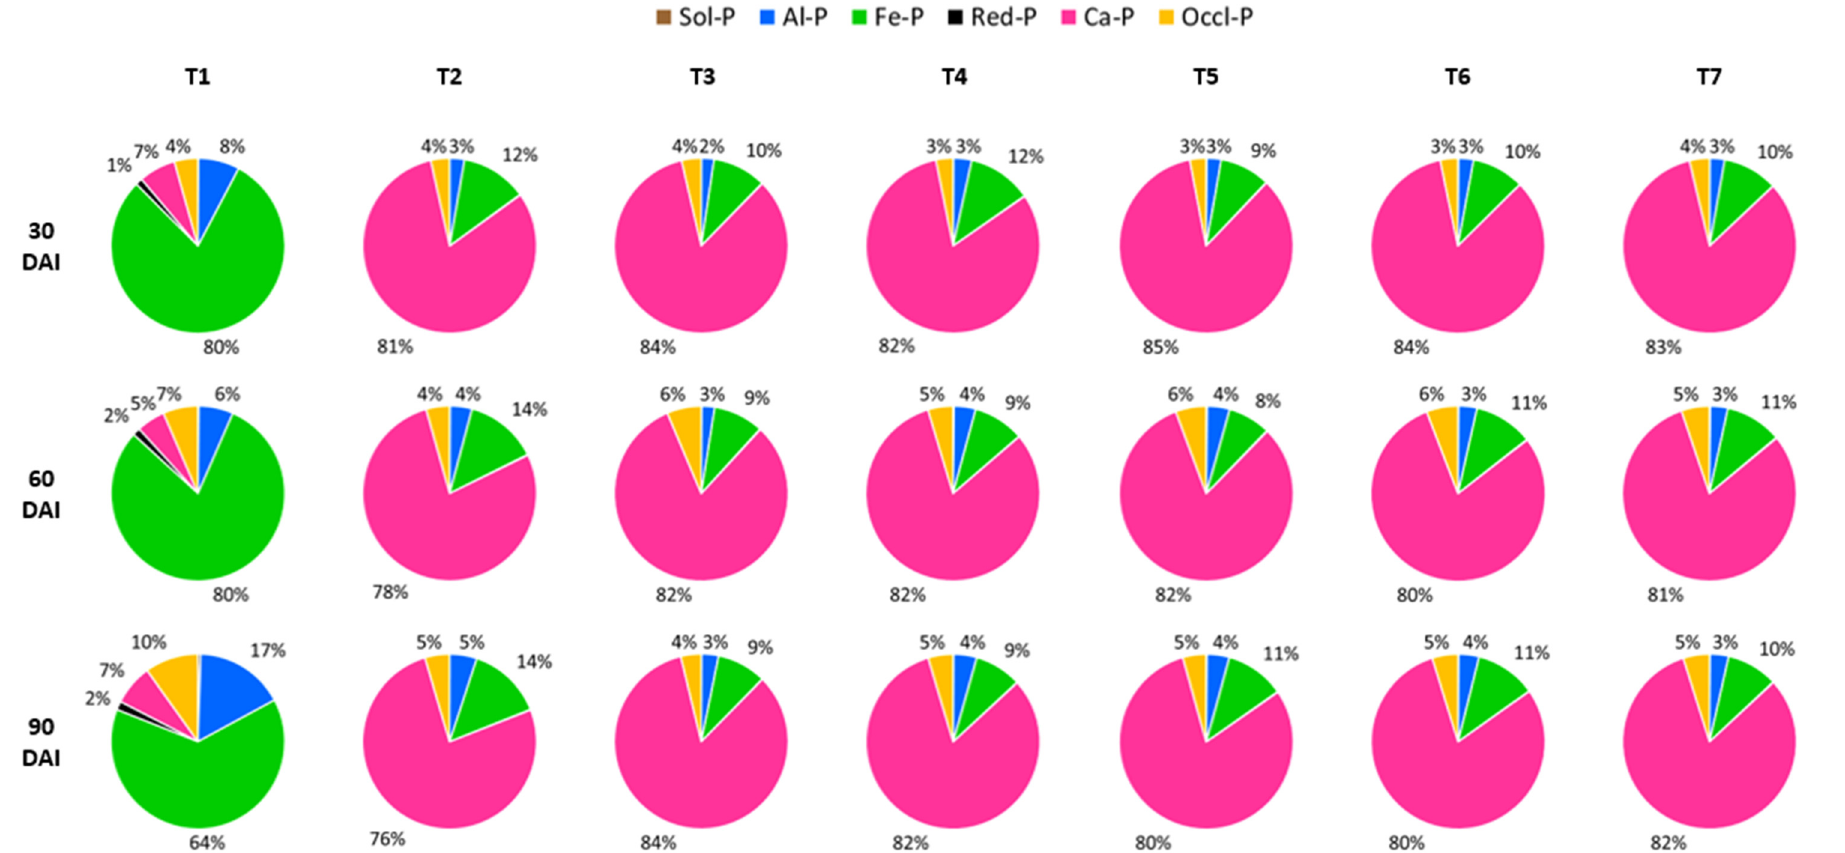
Figure 22. Percentages of soil inorganic phosphorus distribution in T1, T2, T3, T4, T5, T6, and T7 after thirty, sixty, and ninety days of incubation, where T1: soil alone, T2: Egypt rock phosphate alone, T3: Egypt rock phosphate + 100% charcoal, T4: Egypt rock phosphate + 100% sago bark ash, T5: Egypt rock phosphate + 100% charcoal + 100% sago bark ash, T6: Egypt rock phosphate + 75% charcoal + 75% sago bark ash, and T7: Egypt rock phosphate + 50% charcoal + 75% sago bark ash.